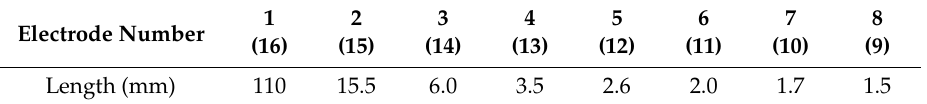
Figure 16. The schematic diagram of the region of interest. Table 3. The actual dimensions of the focusing sensor electrodes used in experimental studies.